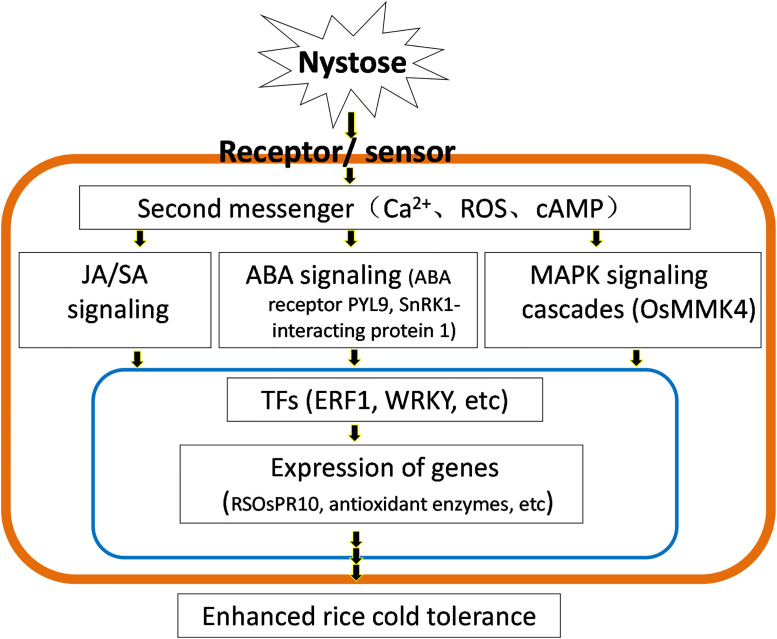
Flow chart of the mechanisms underlying the improvement in cold tolerance of primary rice roots by nystose.